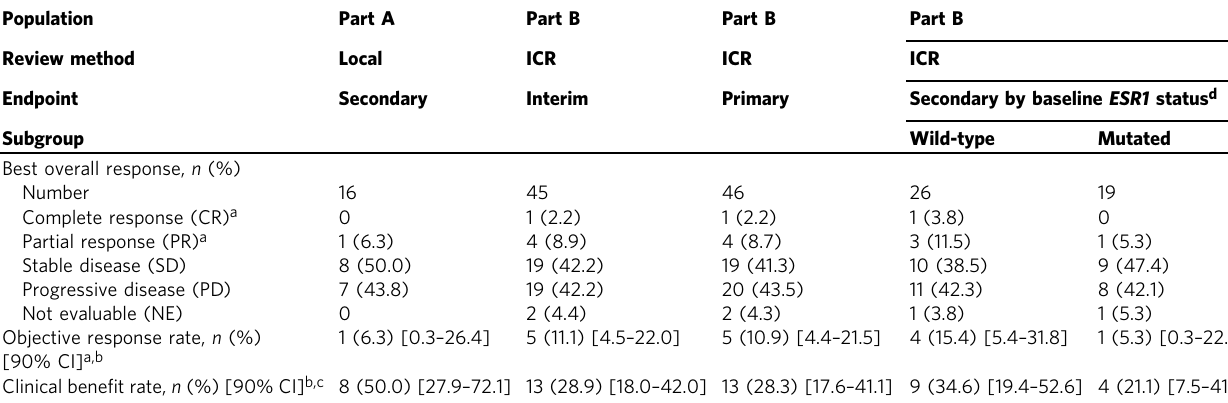
Table 4 Prespeci fi ed analyses of antitumor activity in the response-evaluable populations of Parts A and B. Population